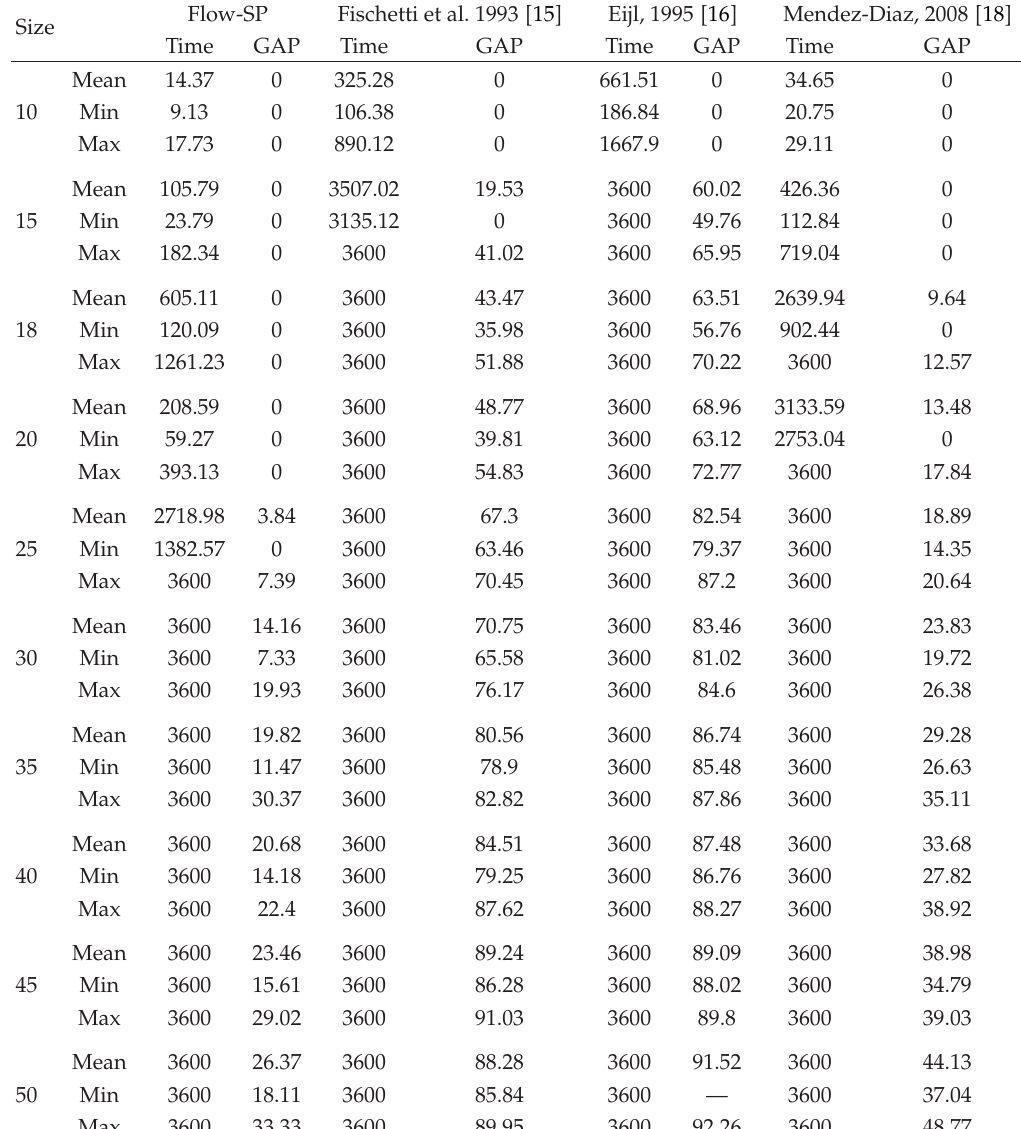
Table 3: Performance of the four models proposed for TRP over randomly generated